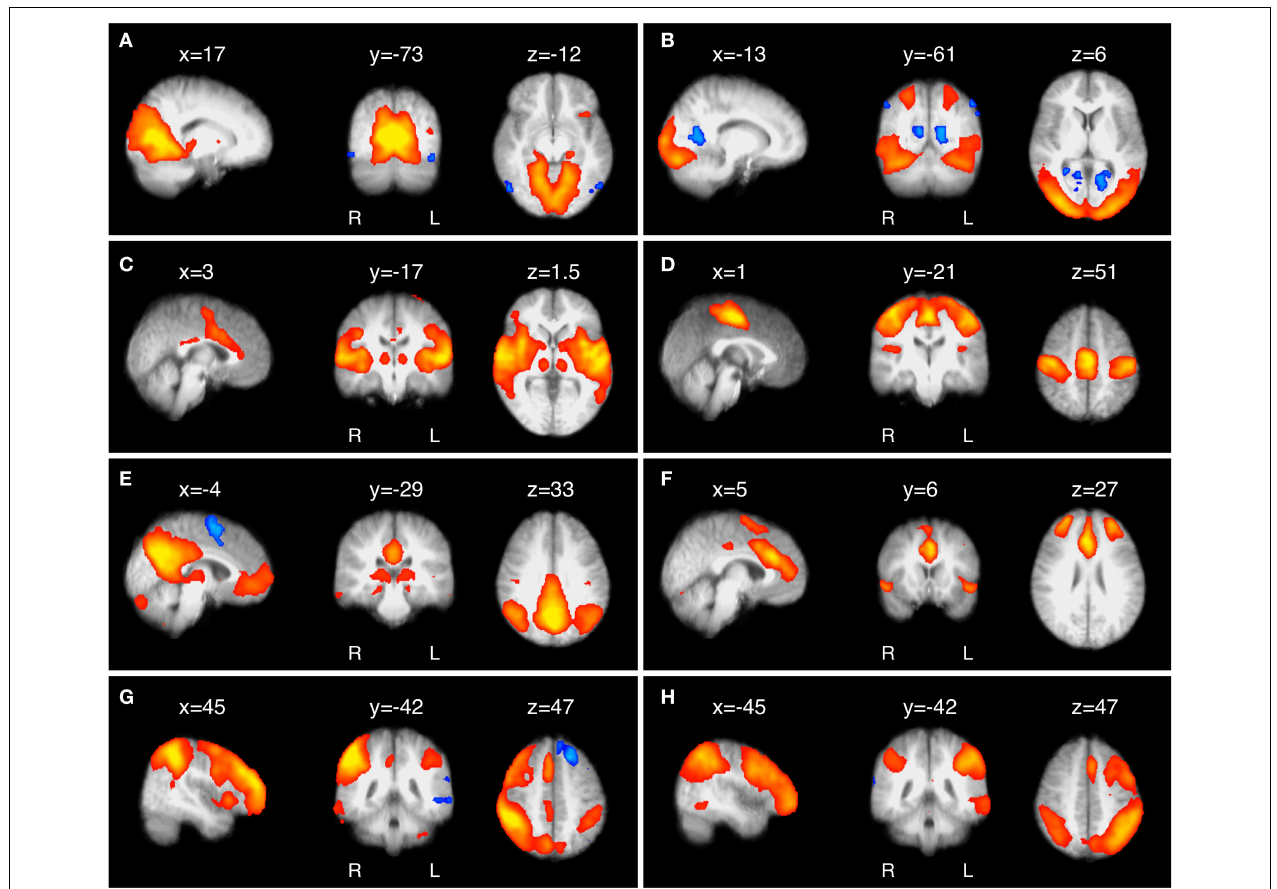
FIGURE 1 | Eight of the most common and consistent RSNs identifi ed by ICA. (A) RSN located in primary visual cortex; (B) extrastriate visual cortex; (C) auditory and other sensory association cortices; (D) the somatomotor cortex; (E) the ‘default mode’ network (DMN), deactivated during demanding cognitive tasks and involved in episodic memory processes and self-referential